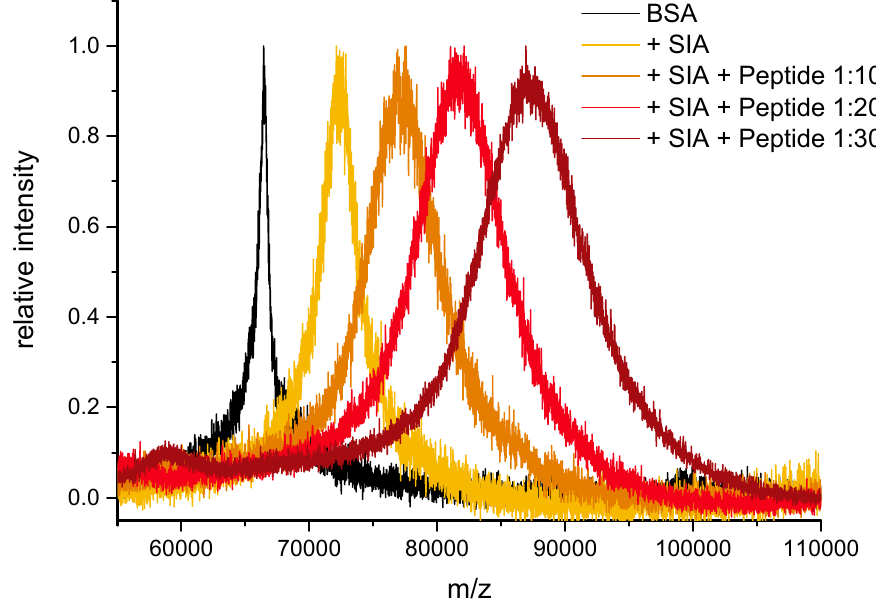
Figure 6. Protocol I (peptide limited): Conjugation of cysteine-containing model peptide with SIA-activated serum albumin (BSA). The + SIA spectrum shows BSA with a three-fold activation step (saturation). The ratio refers to BSA:peptide. Table 4. Protocol I: Quantitative conjugation ratios obtained by different peptide ratios.